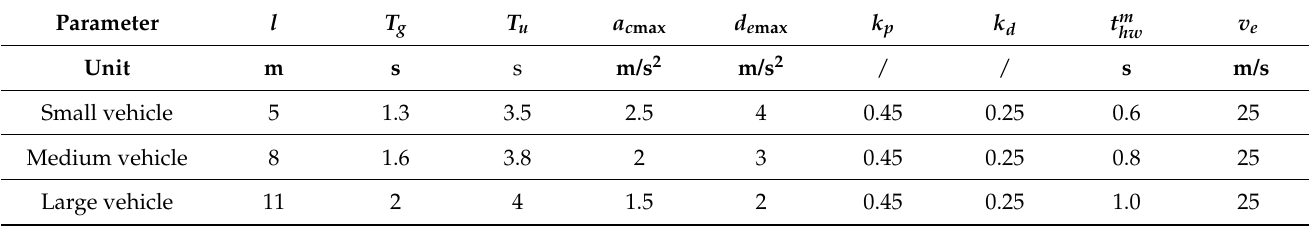
Table A4. Parameter values of